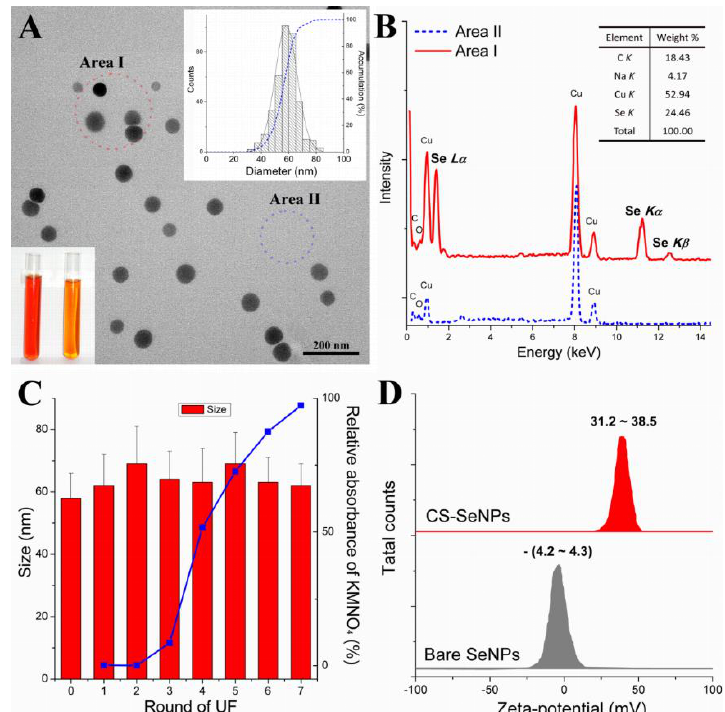
Figure 1. Physicochemical characteristics of CS-SeNPs. ( A ) TEM image, appearance, and size distribution of CS-SeNPs. ( B ) Typical EDS spectra of CS-SeNPs (measured at Area I, Figure 1A) and elemental composition (inset). ( C ) Size of SeNPs after rounds of ultra-filtration (UF) and absorbance (measured at 525 nm) of a KMnO 4 solution mixed with corresponding UF permeates. ( D ) Zeta-potentials of CS-SeNPs (UF Round 0–6) and of bare SeNPs.